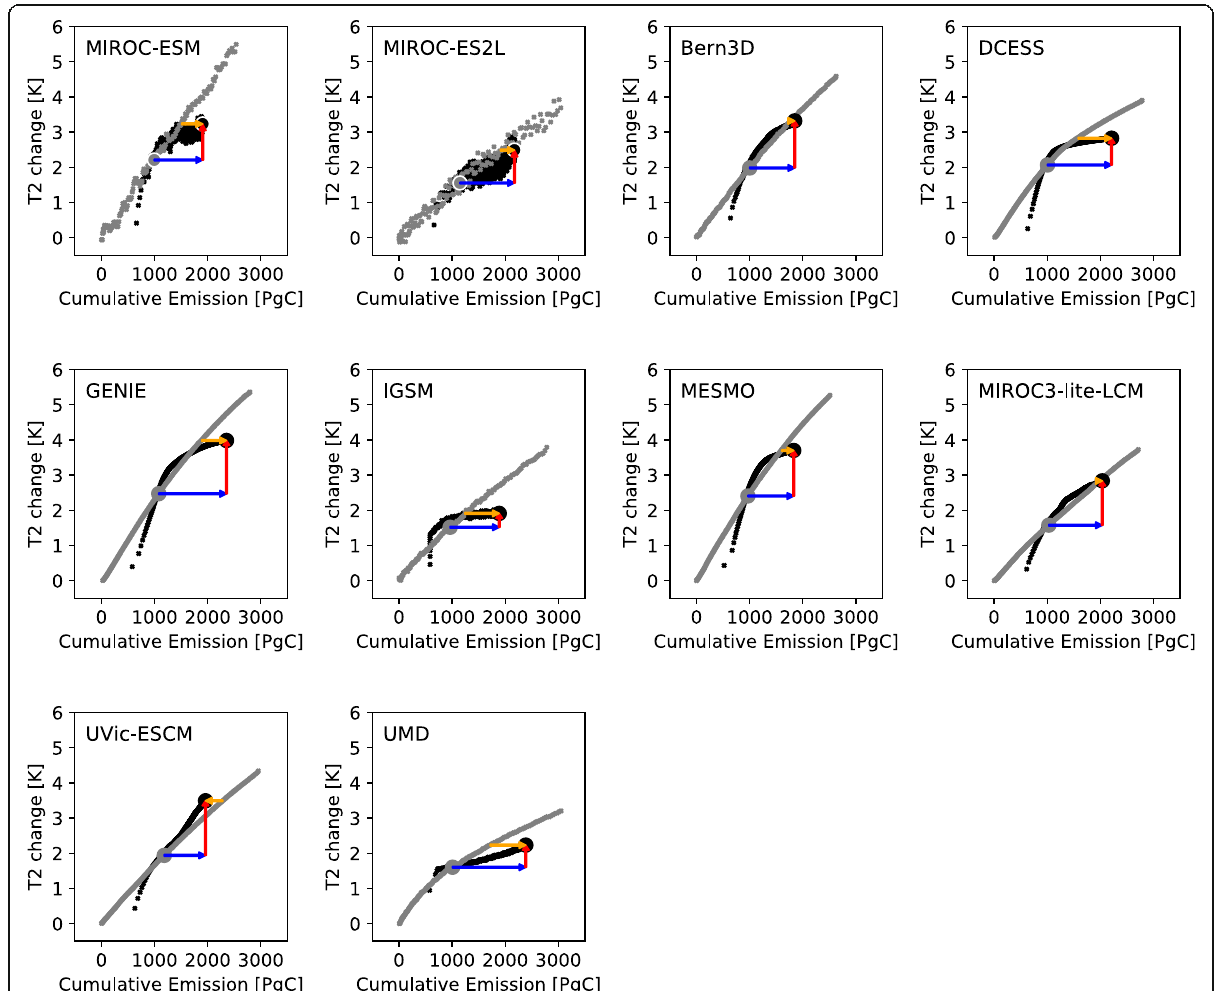
Fig. 5 Relationships between cumulative carbon (C) emission and changes in global mean surface air temperature in the experiments of abruptly doubled CO 2 concentration (FULL 2 × CO2 1000 years; black) and that where CO 2 concentration is increased by 1 % year − 1 (1pctCO2; 140 years; gray) by two ESMs (MIROC-ESM and MIROC-ES2L) and eight EMICs from EMIC-AR5 (Eby et al. 2013; Zickfeld et al. 2013). Gray-filled circles represent the time when the CO 2 concentration reaches about 2 × CO 2 level in 1pctCO2 (calculated as the average of years 61 – 80); black-filled circles represent the final condition of the FULL 2 × CO2 experiment (calculated as the average of years 981 – 1000). Red, blue, and orange arrows indicate the unrealized warming ( Δ T UNR ), unrealized C uptake ( Δ C UNR ), and additional C uptake ( Δ C ADD ), as defined in Fig.